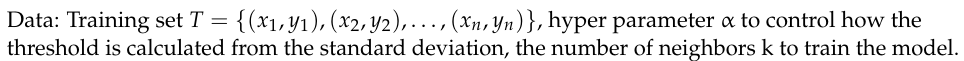
Algorithm 1: RegENN: Edited Nearest Neighbor for regression using a